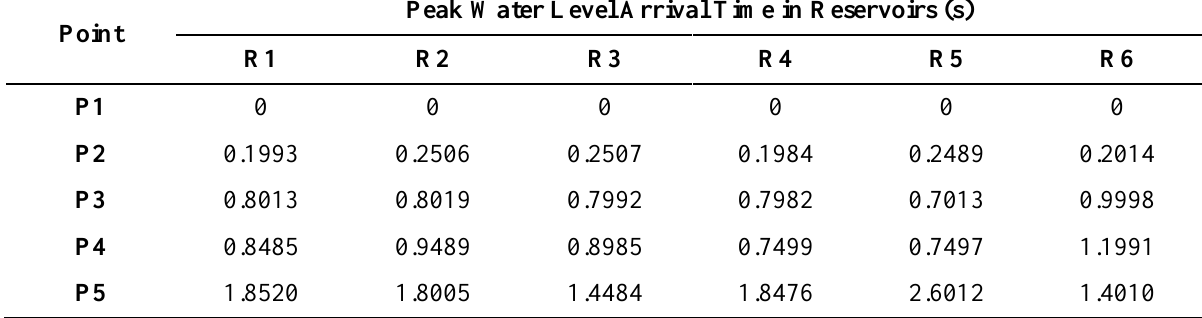
Arrival times for peak water levels.